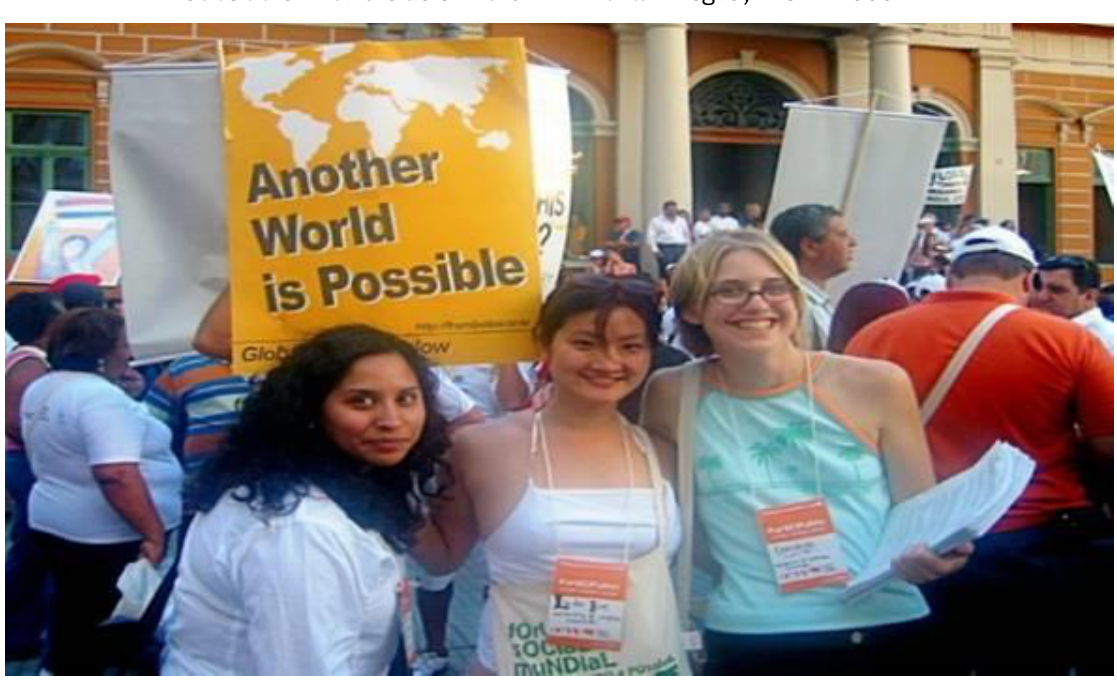
Figure 3. UCR Sociology Graduate Students Erika Gutierrez, Linda Kim and Christine Petit at the World Social Forum in Porto Alegre, Brazil